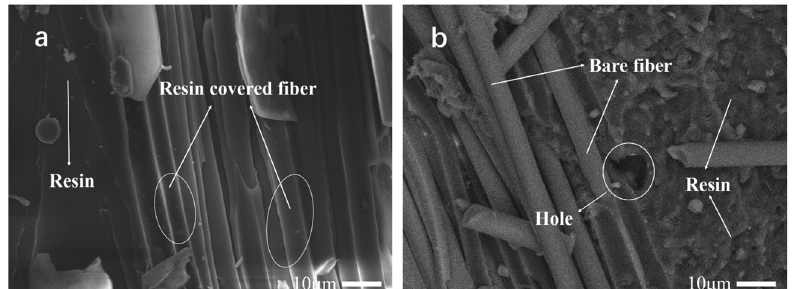
Figure 11: SEM images of interface of composites: ( a ) A - 0 and ( b ) A